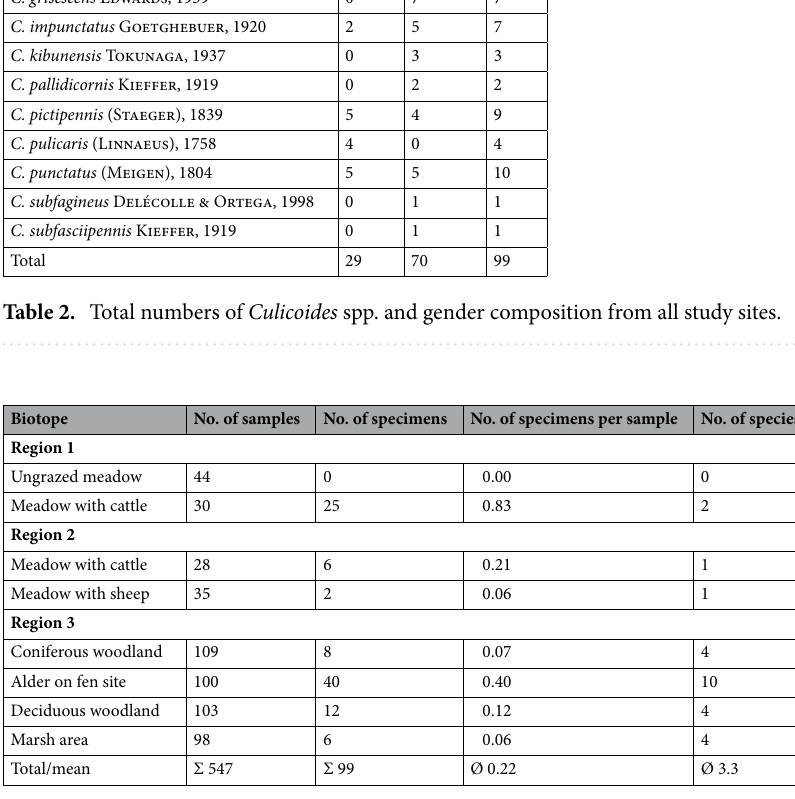
Table 3. Quantitative composition of culicoid biting midges per biotope.